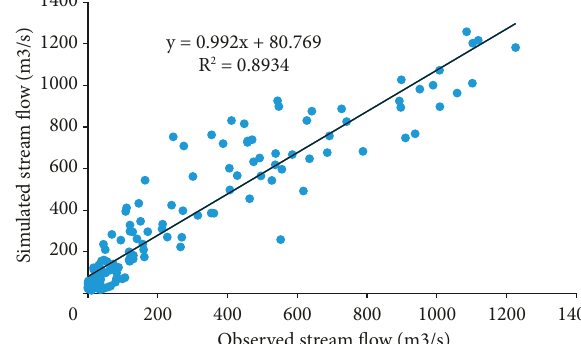
Figure 13: Scatter plots of observed and simulated monthly streamflow for the Nashe watershed during the calibration period.